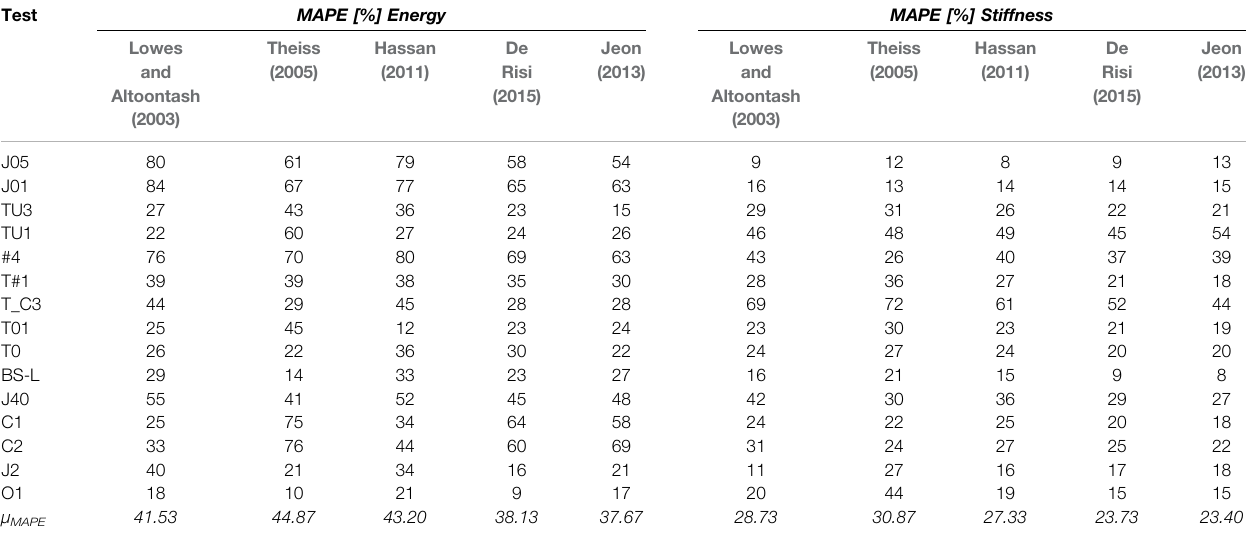
TABLE 11 | Mean absolute percentage errors for energy dissipation and stiffness degradation.